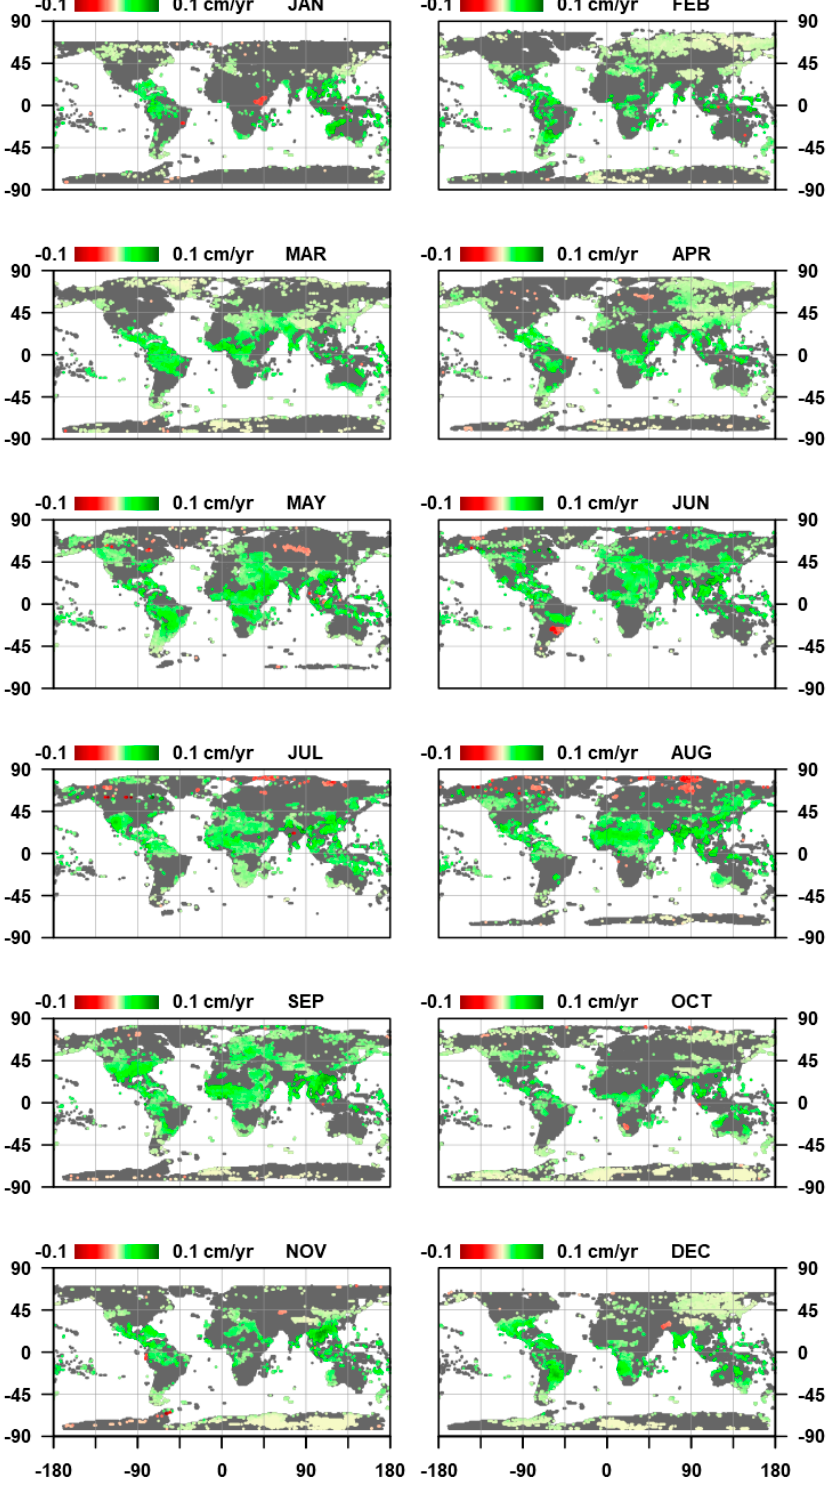
Figure 4. Long-term trend of annual water vapor averages per month (2000–2018). Only significant trends ( α = 0.05) are shown.